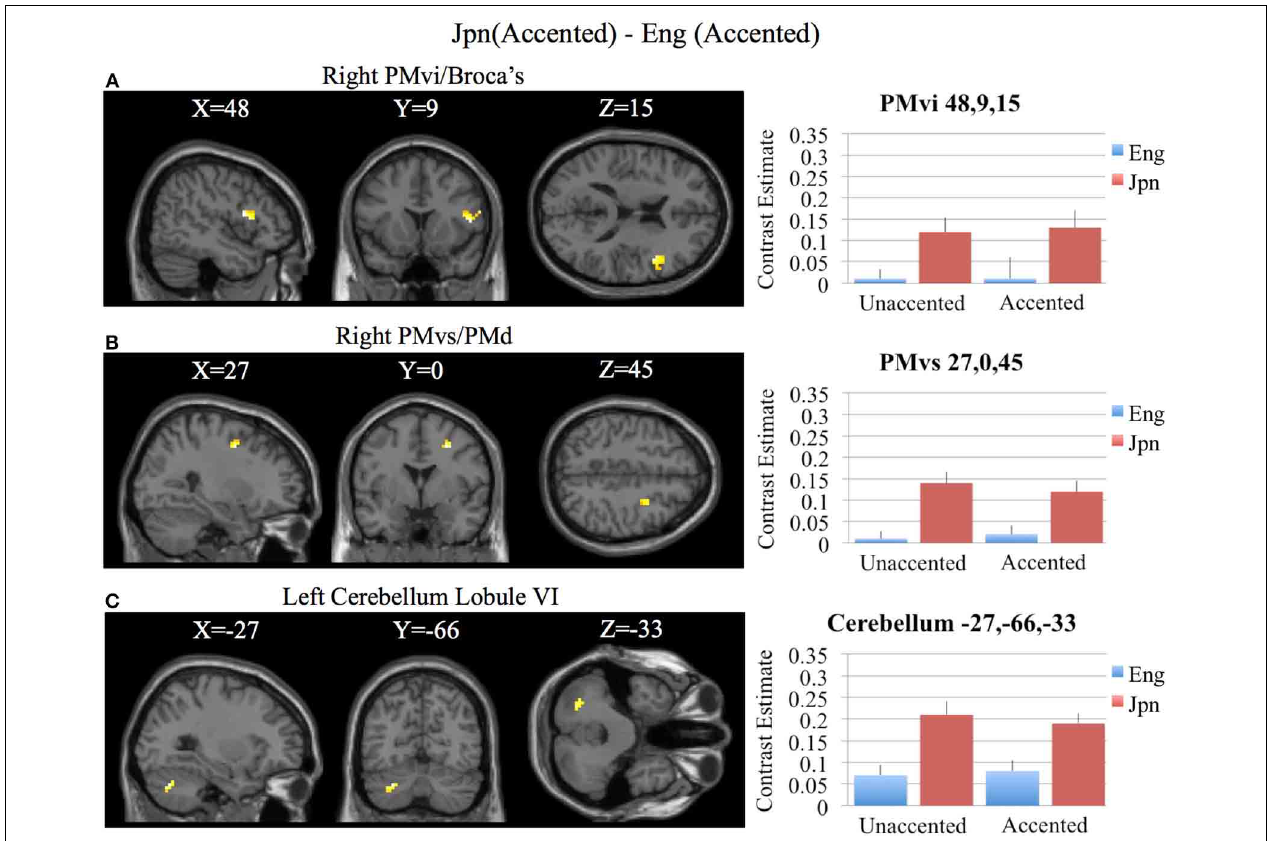
FIGURE 6 | Region of interest analysis for the contrast of Jpn(accented) – Eng(accented) using small volume correction ( p < 0 . 05) for multiple comparisons. (A) Right PMvi/Broca’s area. (B) Right PMvs/PMd. (C) Left Cerebellum Lobule VI. MNI X, Y, Z coordinates are given